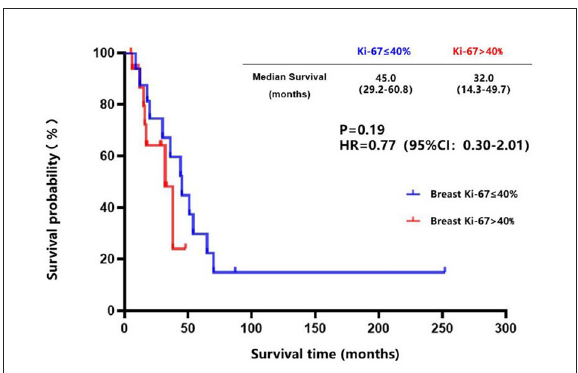
FIGURE7 Kaplan-Meier curves of the metastasis-free survival in breast cancer patients with brain metastasis whose Ki-67 of ≤ 40% compared to those with Ki-67 of > 40% in the primary lesions.